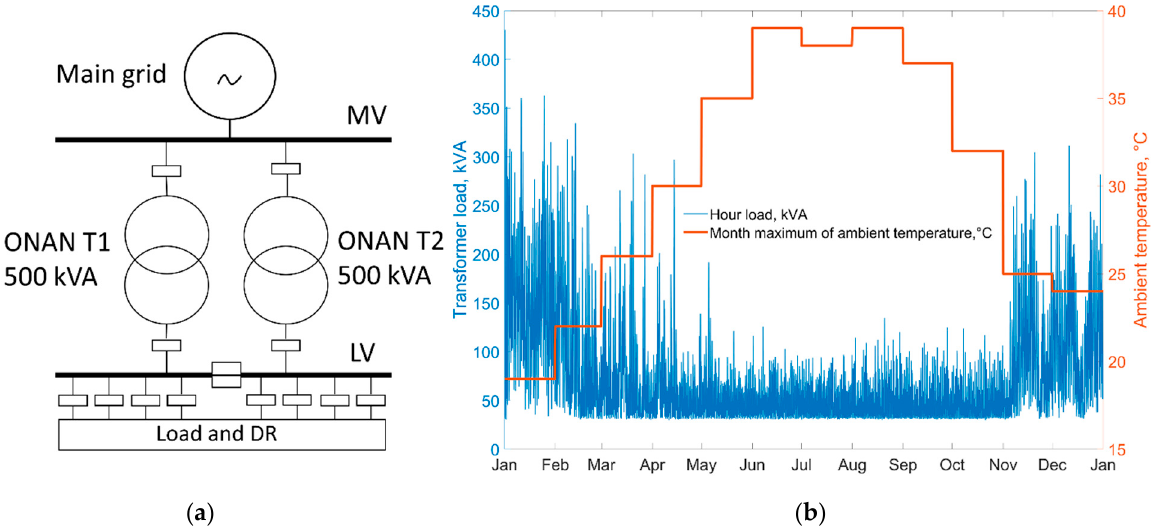
Figure 2. Case study—( a ) outdoor secondary substation; ( b ) hourly load in kilovolt ampere (kVA) and monthly maximum ambient temperature ( θ a ) in Grenoble, France.